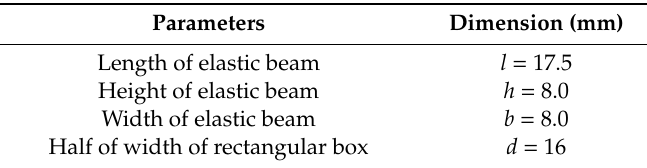
Table 1. Dimension parameters of the sensor.